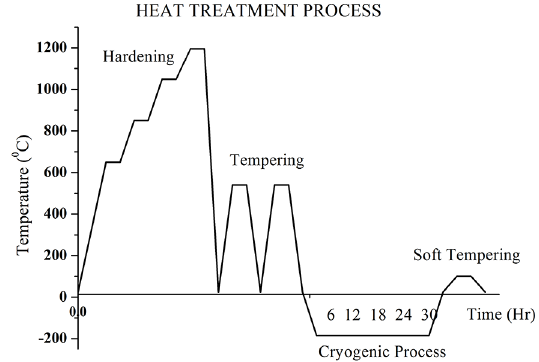
Figure 1. Time-Temperature diagram illustrates the heat treatment employed on H21 tool steel